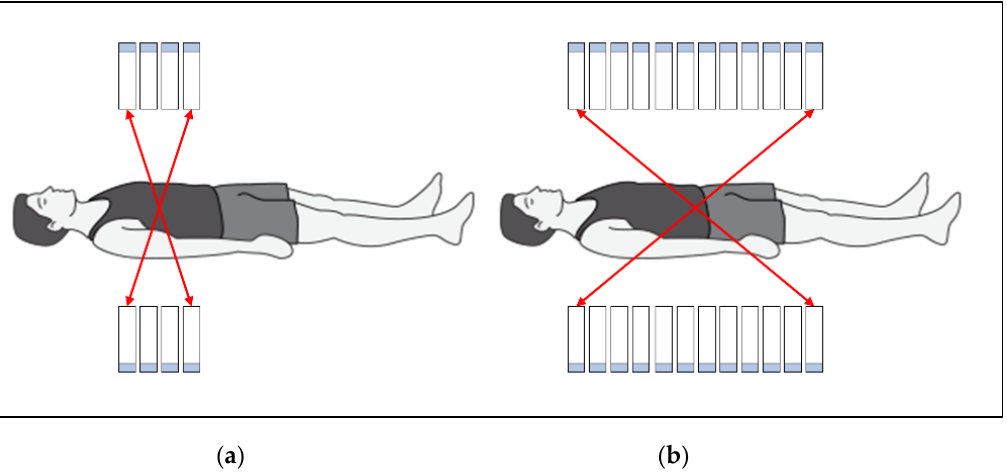
Figure 5. ( a ) Scanning field of the traditional Wb-PET scanners and ( b ) scanning field of the long- AFOV PET.